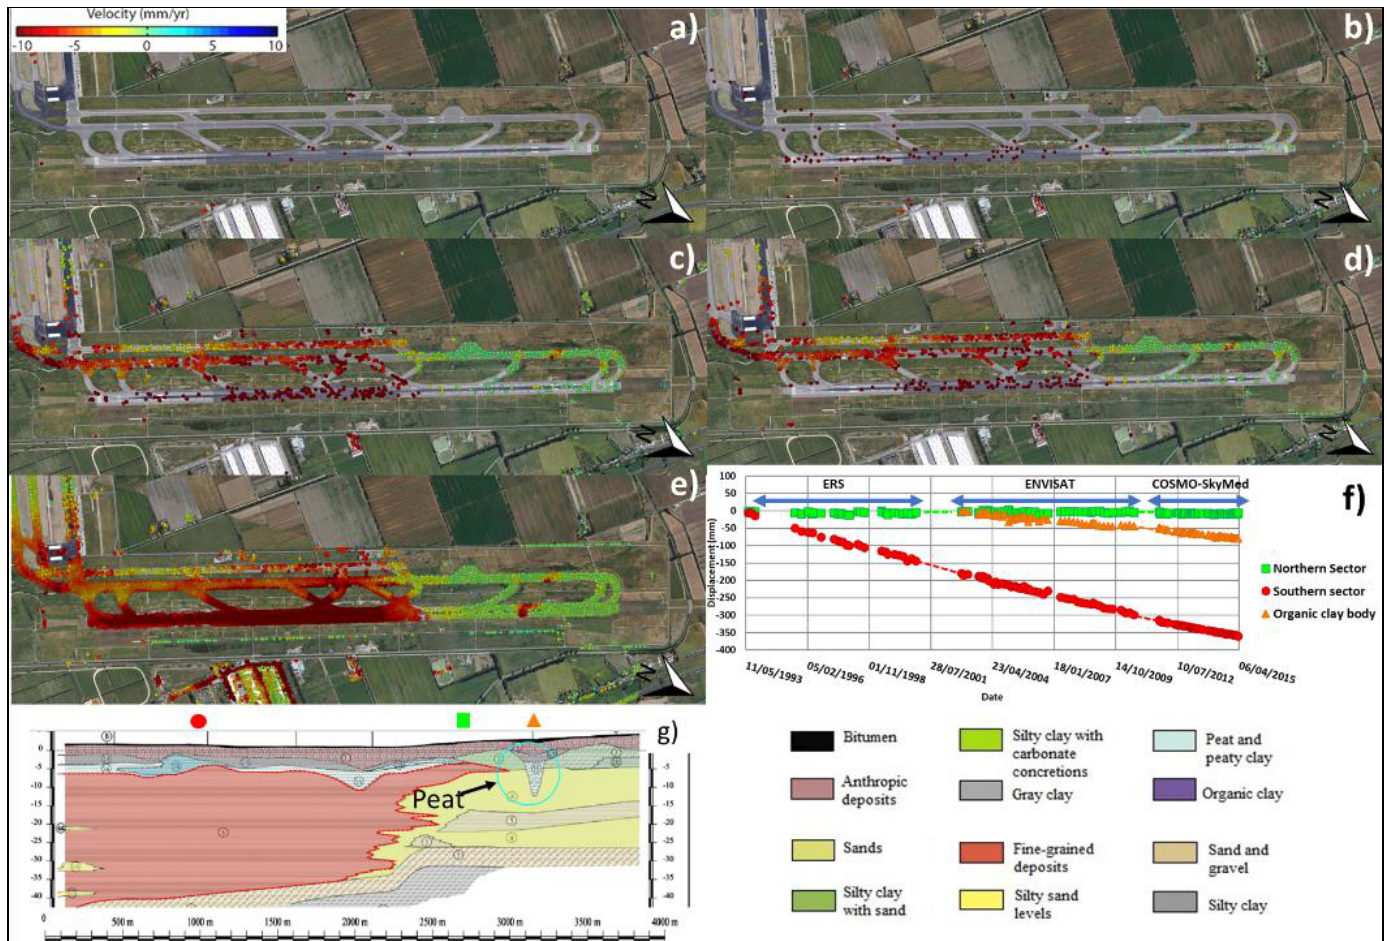
Figure 11 . Ground deformation of airstrip 3 of the Leonardo Da Vinci airport analysed by ERS ascending ( a ); ERS descending ( b ); ENVISAT ascending ( c ); ENVISAT descending ( d ); and COSMO-SkyMed ( e ). In ( f ) are reported the cumulative time series of displacement of the three main sectors detected at the airstrip. In ( g ) a geological cross section of the airstrip is shown (from Manassero and Dominijanni [46], redrawn). The location of this region is reported in Figure 6f.